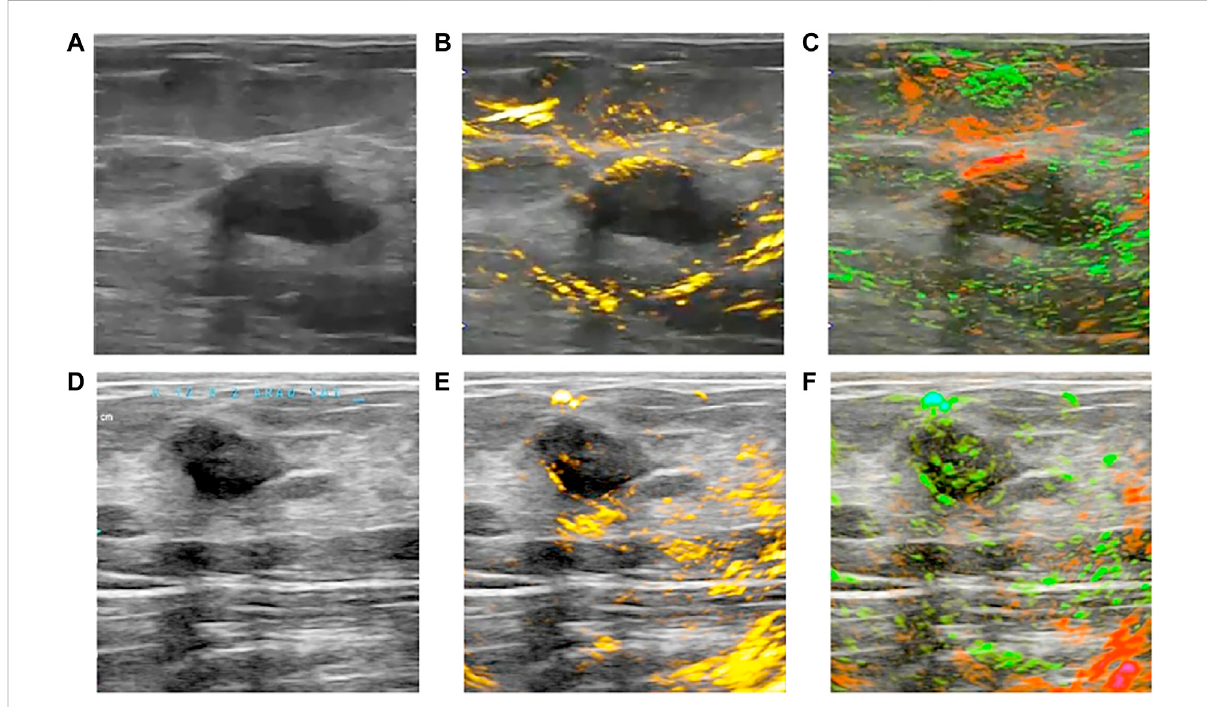
FIGURE 4 Clinical OA/US imaging of two benign breast tumors. (A,D) show US of two breast tumors; (B) reveals a lack of angiogenesis microvasculature within the breast tumor in OA/US image; (C) shows the majority of the tumor is normally oxygenated in OA/US image; (E, F) display another similar breast tumor in OA/US image. OA: optoacoustic; US: ultrasound. Reprinted with permission from Oraevsky et al.